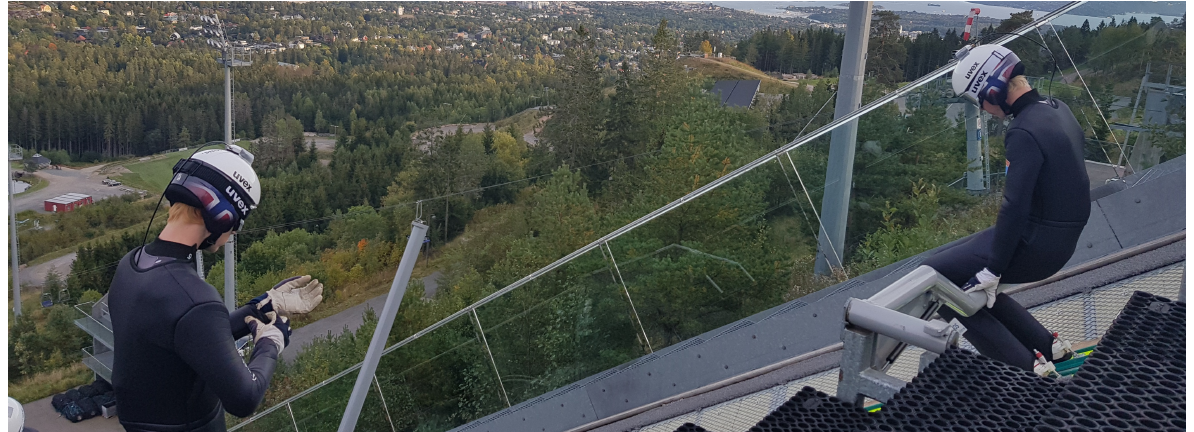
Figure 2. Ski jumpers with the dGNSS antennae mounted on their helmets and the receivers in backpacks that were carried under the ski jumping